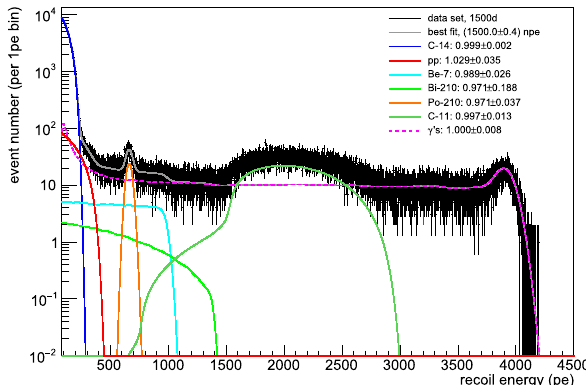
Fig. 5 Energy spectrum and spectral fit as expected for the default scenarioofSerappis(seetext).Boththedataspectrumandthefitinclude only the spectral components potentially relevant for the fit uncertainty of the pp rate, i.e. pp and 7 Be recoil spectra as well as the dominant internal radioactive backgrounds 14 C, 210 Bi, 210 Po, cosmogenic 11 C as well as external γ rays. The resulting relative uncertainty for the pp rate is 3.4% for a 1500-day measuring time. Crucially, pile-up events from 14 C that are of special importance for Borexino [3] can be neglected